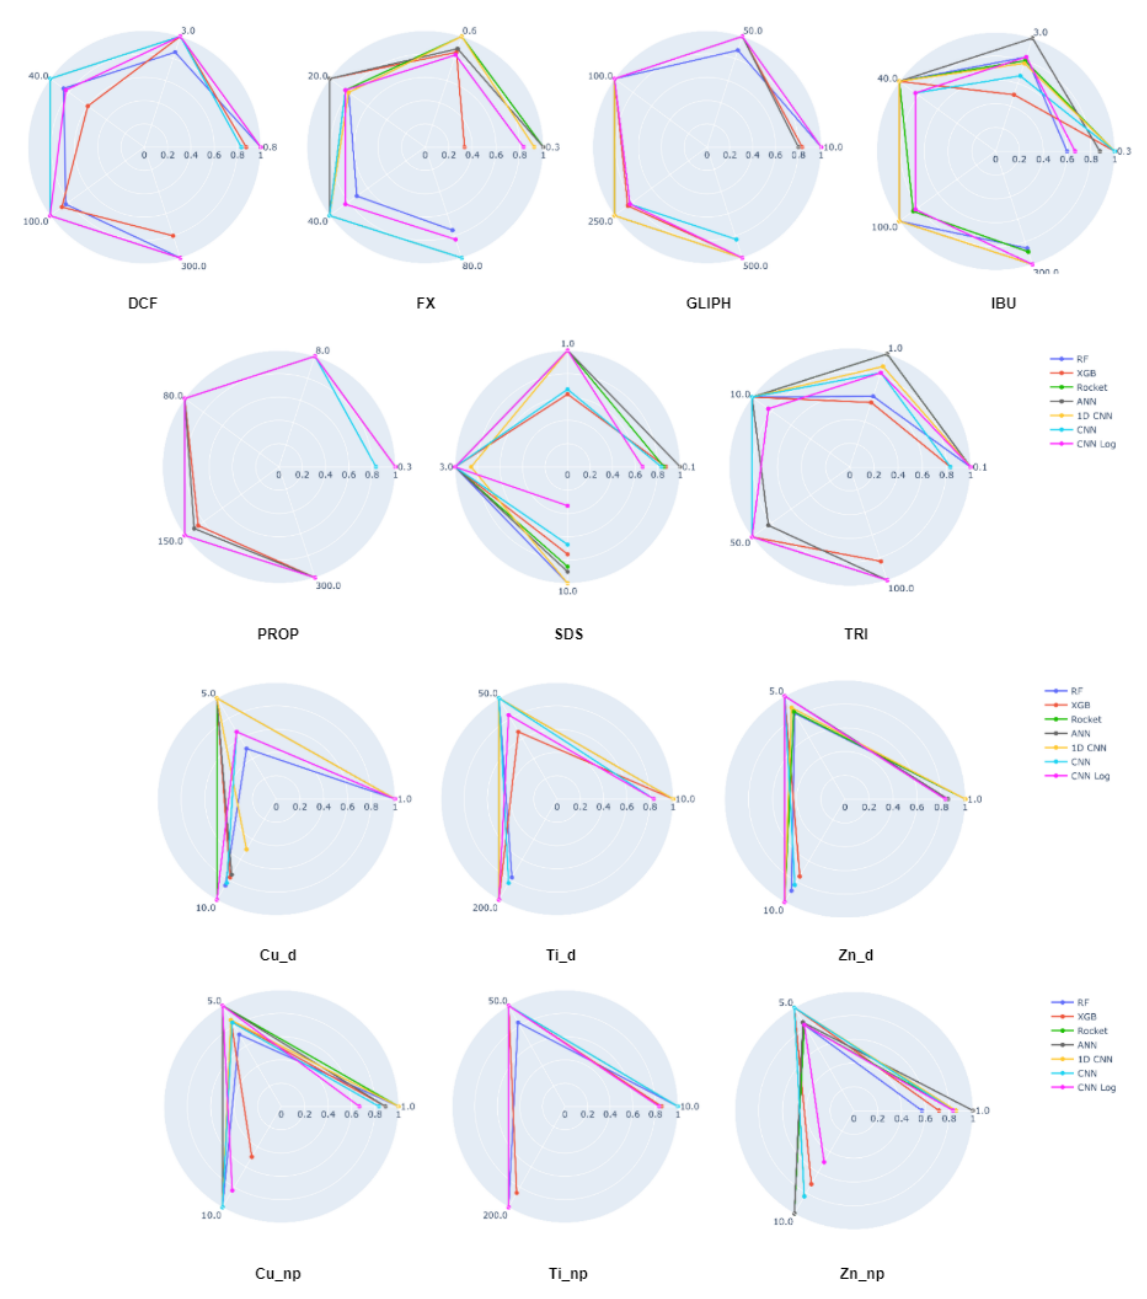
Figure 7. Spider plots depicting the accuracy per class of each model when predicting the different concentrations of an EC. Each vertex within the circle corresponds to the concentration of that